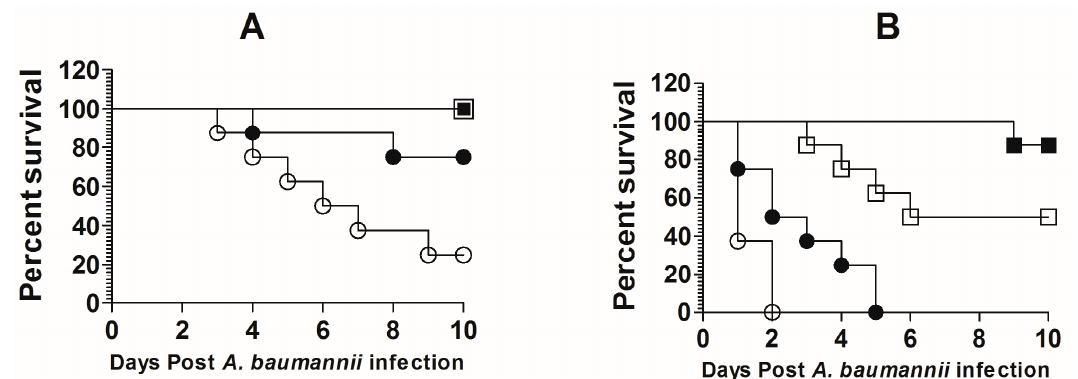
Figure 3. Standardization of the infectious dose of A. baumannii in mice. ( A ) Immunocompetent and ( B ) leukopenic mice were infected with various CFUs of A. baumannii and their survival was monitored for 10 days. ( (cid:110) ) 5 × 10 5 , ( (cid:3) ) 1 × 10 6 , ( (cid:108) ) 5 × 10 6 , ( ) 1 × 10 7 .